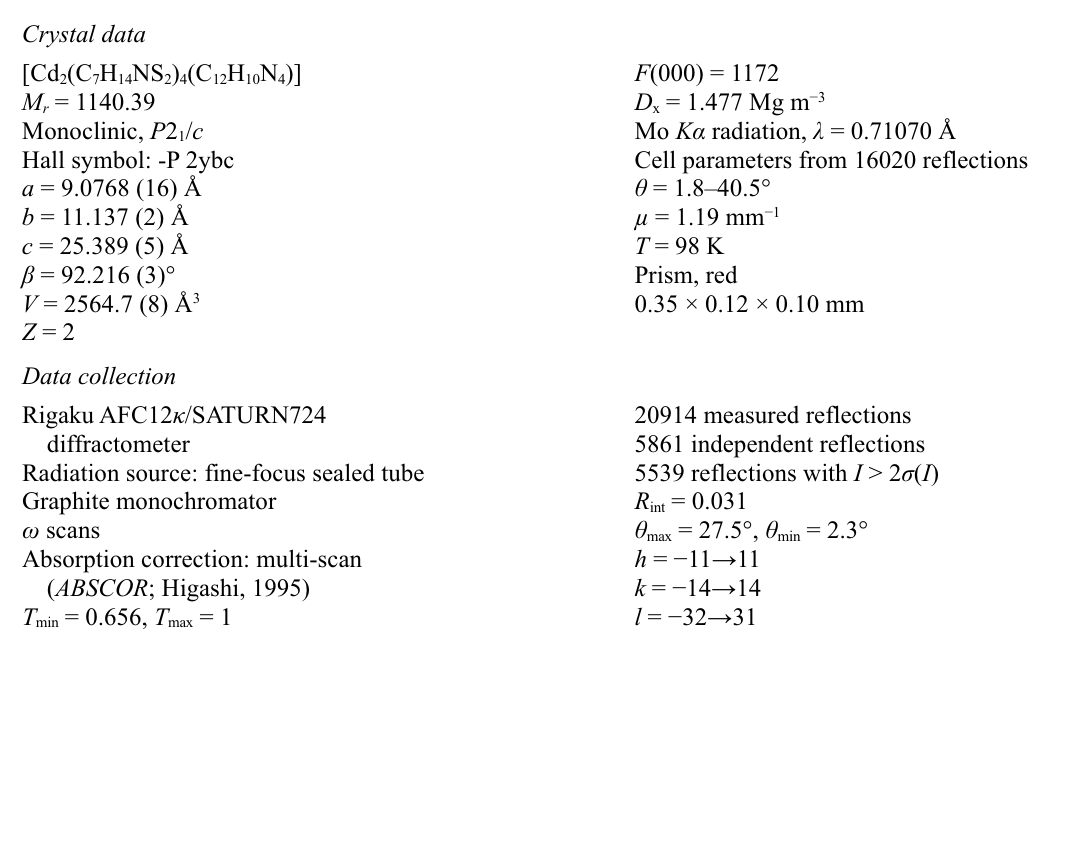
Figure 3 View in projection of the crystal packing in (I). Colour code as for Fig. 2. ( µ -2-Pyridinealdazine- κ 4 N , N ′ : N ′′ , N ′′′ )bis[bis(N,N-di-n- propyldithiocarbamato- κ 2 S , S ′